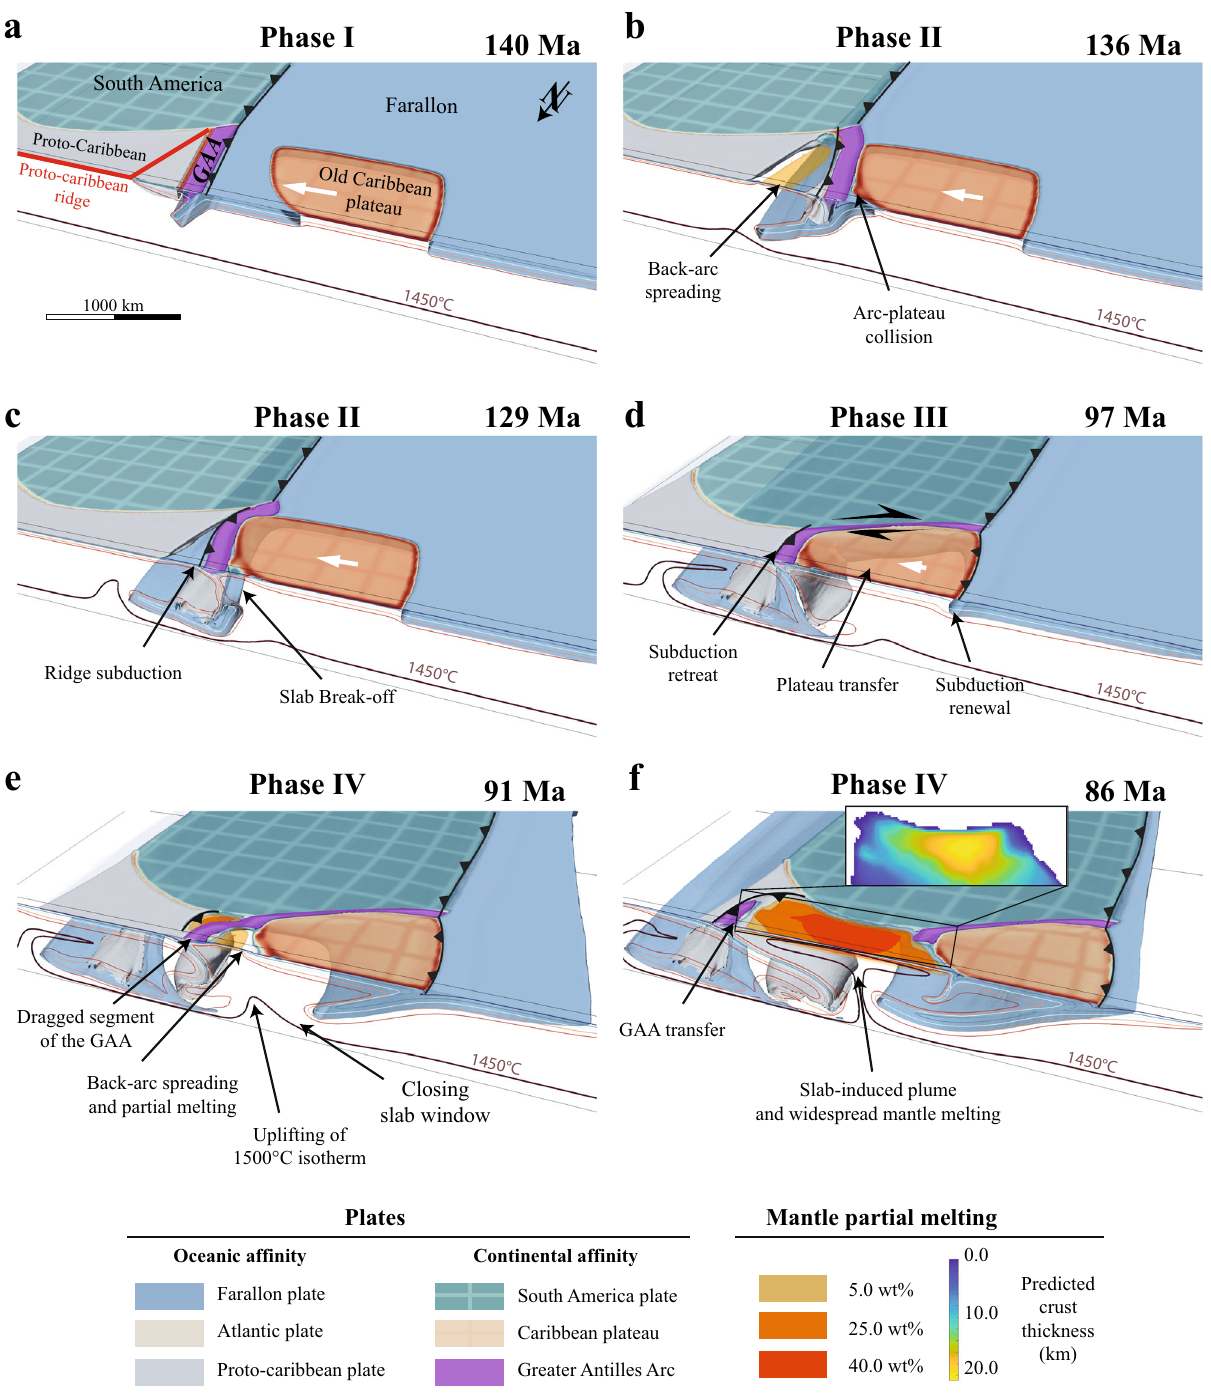
Fig. 2 | Reference simulation results. a initial conditions. b collision between old Caribbean plateau and Greater Antilles Arc (GAA). During this phase east-directed subduction of the Farallon locally ceases and west-directed subduction of the proto-Caribbean plate initiates (Polarity-reversal subduction initiation). c plateau transfer phase and mantle window opening. d subduction initiation of Farallon plate at the western edge of the Caribbean plateau. e Triggering of a subduction-